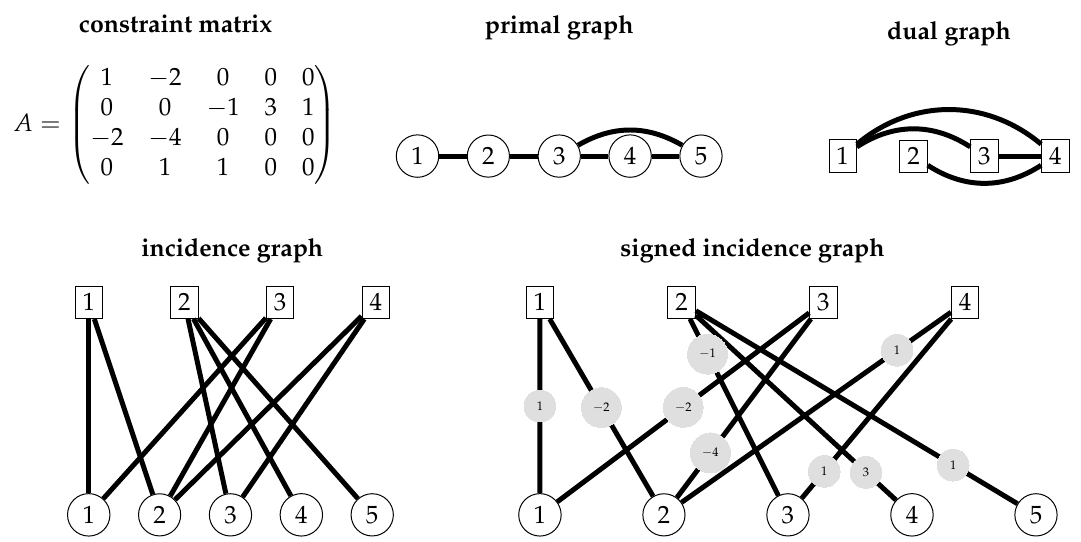
Figure 2. The primal, dual, incidence, and signed incidence graph of the constraint matrix shown in the top left corner. Vertices corresponding to variables (constraints) of the matrix are indicated by circles (rectangles). The label of a vertex corresponds to its row/column-index in the constraint matrix. For a decompositional width measure dw ∈ { td, tw, cw, scw } , we denote by dw SI ( I ) , dw I ( I ) , dw P ( I ) , dw D ( I ) , the width of the signed incidence graph, the incidence graph, the primal graph, and the dual graph of I ,